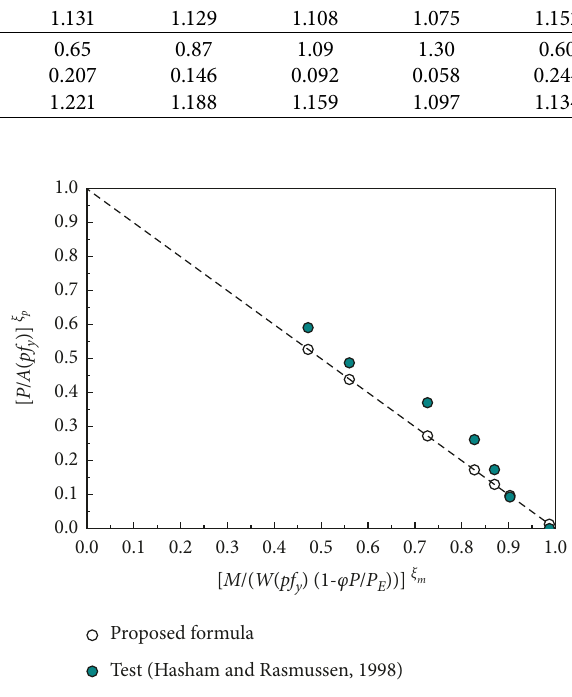
Figure 14: Comparison between the proposed formula and existing test result.